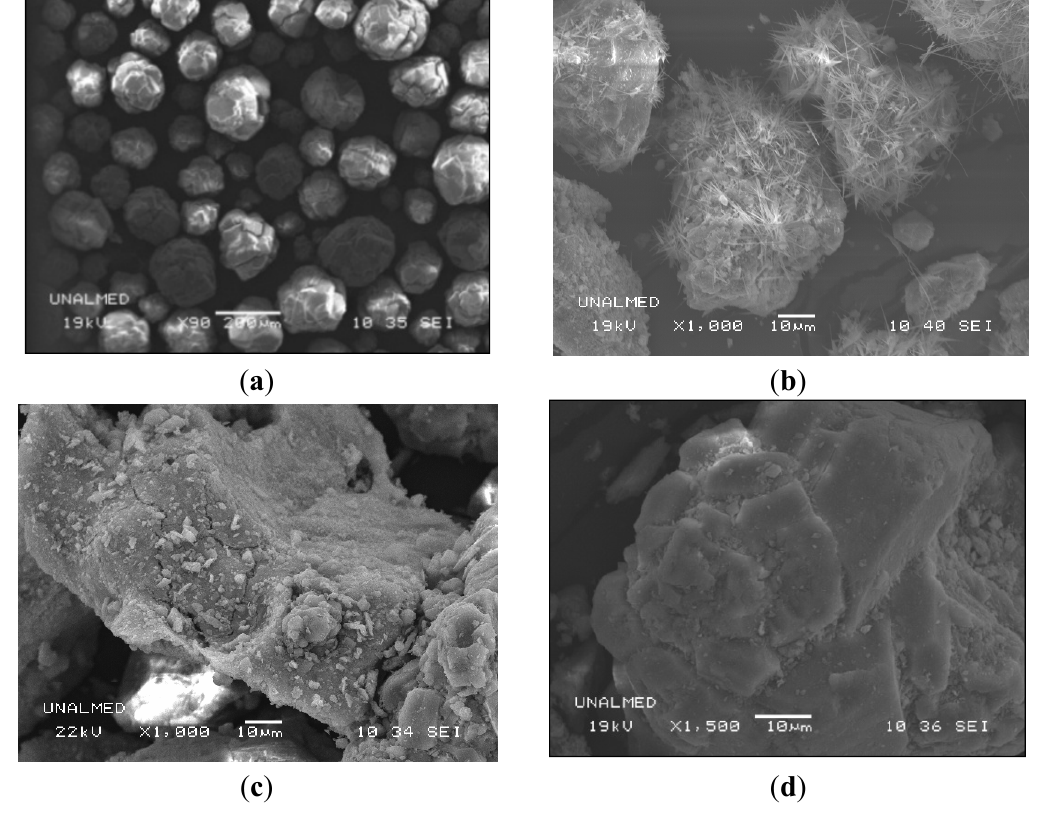
O ; ( b ) MnAlT400; ( c ) MnAlT400W and ( d ) 2 3